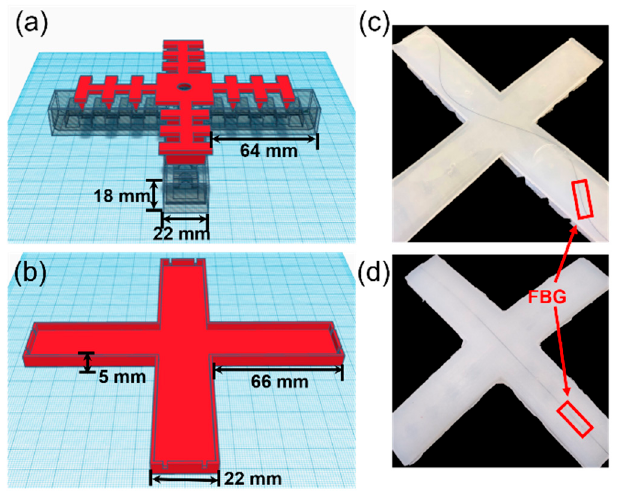
Figure 1. ( a ) 3D molds for fabricating the top part of the soft gripper; ( b ) 3D molds for fabricating the gripper base; ( c ) soft gripper with sinusoidally embedded FBG sensors; and ( d ) soft robotic gripper with straightly embedded FBG sensors. FBGs are indicated by the red